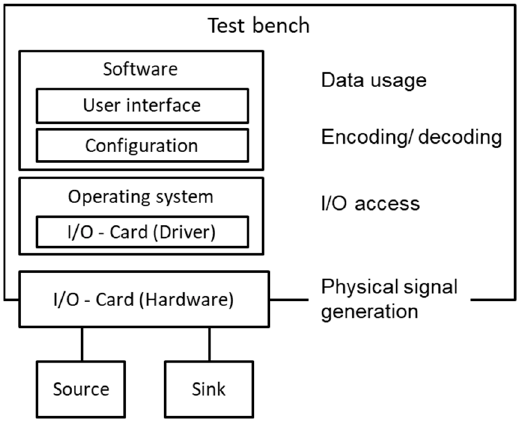
Figure 7. Test bench in the layer representation with data/signal transformation, according to VDI 2882.